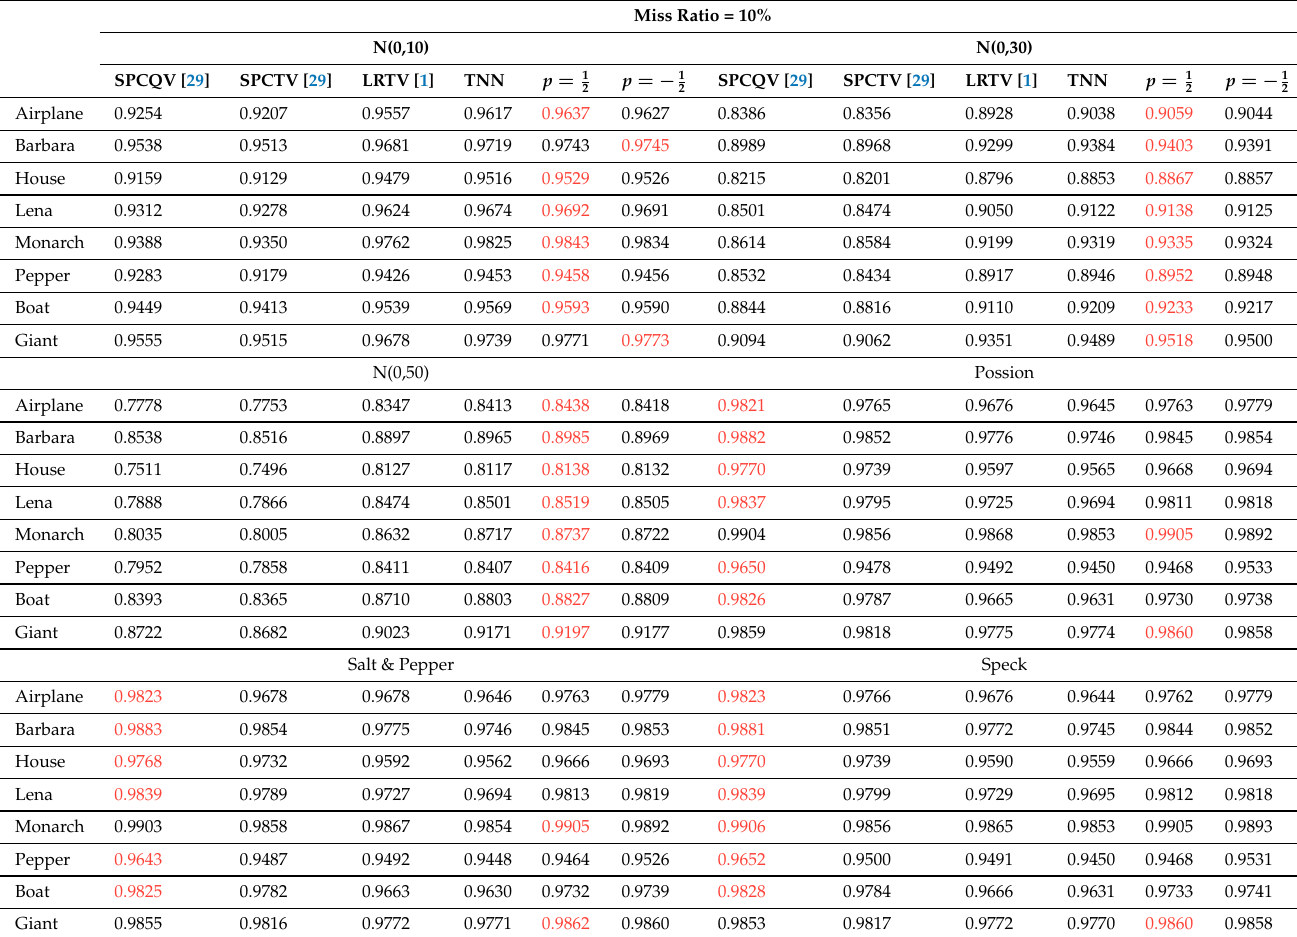
Table 2. Comparisons of SSIM for images with 10% missing elements, where red is the best